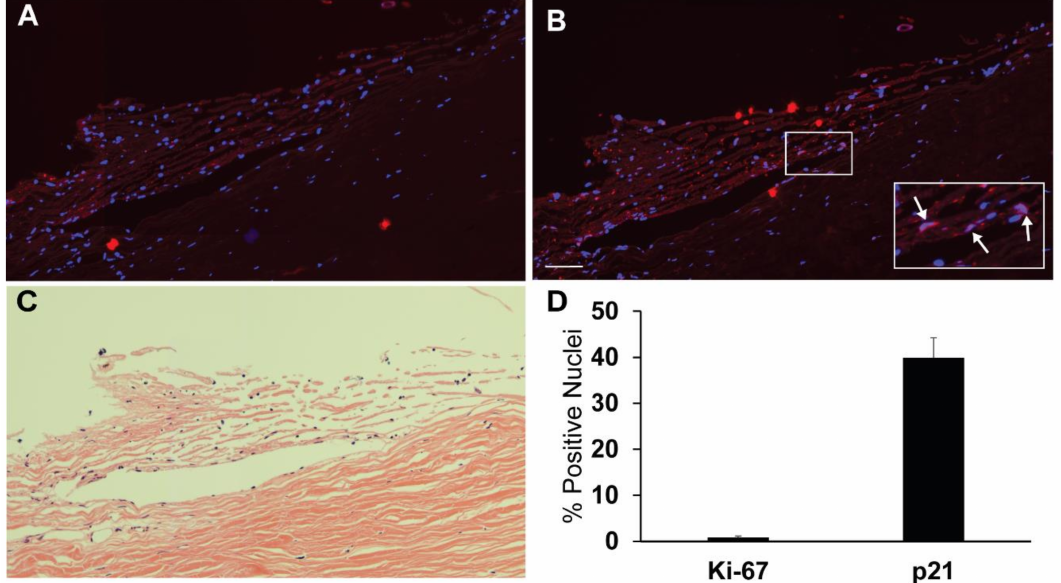
Figure 1. Human anterior segment labeled for proliferation marker Ki-67 and cyclin inhibitor p21. Paraffin-embedded anterior segments of normal human eyes were labeled as indicated in Methods for nuclei, Ki-67 or p21. Images shown here are representative of 5 anterior segments from different donors. ( A ) An 80-year-old female anterior segment labeled for nuclei (blue) and Ki-67 (red). ( B ) Same anterior segment labeled for nuclei (blue) and p21 (red). Enlarged inset shows nuclei positive for p21 labeling as indicated by white arrows. Scale bar = 50 um. ( C ) Hematoxylin and eosin staining of same eye as in ( A , B ). ( D ) Average percent of nuclei labeled with Ki-67 or p21 in the trabecular meshwork. n = 22 wedges from 5 trabecular meshworks of differently aged